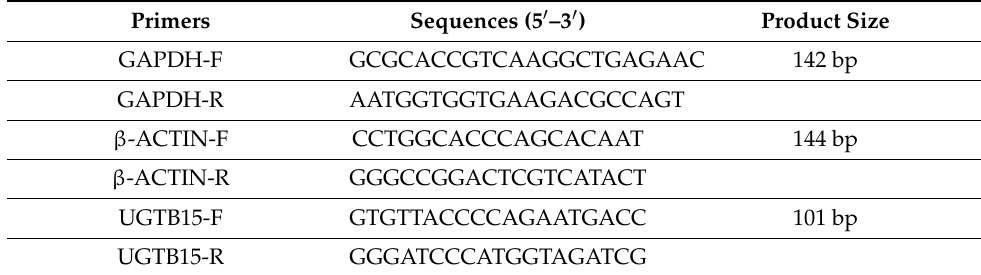
Table 1. Primer sequences for PCR and product